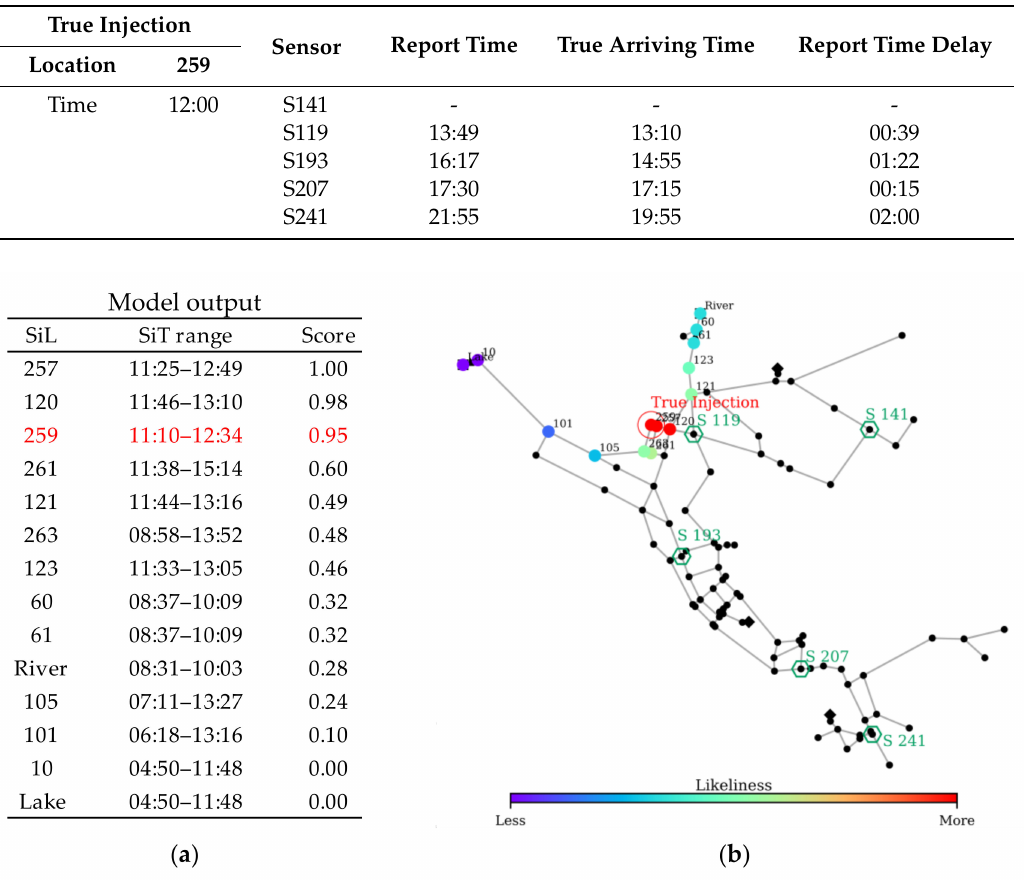
Figure 12. CPSITE simulation results of scenario 2: ( a ) Model output and ( b ) SiL